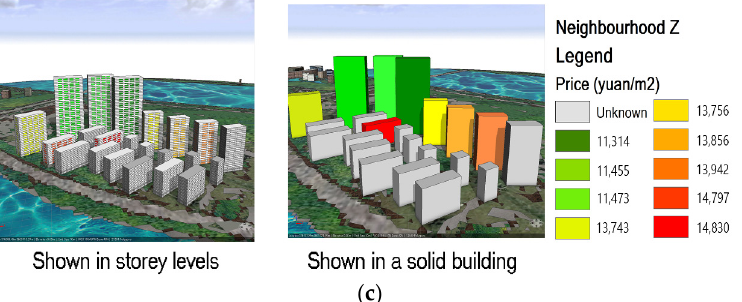
Figure 5. The 3D analysis of Z as theexample. ( a ) Helicopter view of Z with building number; ( b ) detailed screenshots in storey levels; and ( c ) value variation in different presentations. Since the average value per building is used, one colour is set up per building.